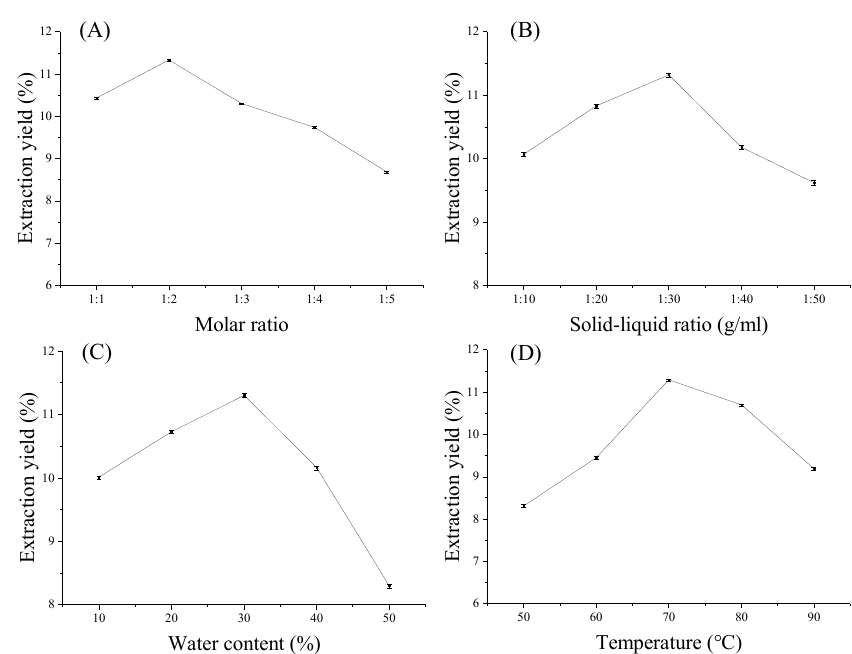
Figure 1. ( A ) Effect of different molar ratios on the extraction yield of crude polysaccharides. Expeimental conditions: water content of 30% (v/v), solid–liquid ratio of 1:30 (g/mL), extraction temperature of 70 °C, sonication time of 30 min, amplitude level of 40%; ( B ) Effect of different solid-liquid ratios on the extraction yield of crude polysaccharides. Expeimental conditions: molar ratio of 1:2, water content of 30% (v/v), extraction temperature of 70 °C, sonication time of 30 min, amplitude level of 40%; ( C ) Effect of different water content on the extraction yield of crude polysaccharides. Expeimental conditions: molar ratio of 1:2, solid–liquid ratio of 1:30 (g/mL), extraction temperature of 70 °C, sonication time of 30 min, amplitude level of 40%; ( D ) Effect of different extraction temperature on the extraction yield of crude polysaccharides. Experimental conditions: molar ratio of 1:2, solid-liquid ratio of 1:30 (g/mL), water content of 30% (v/v), sonication time of 30 min, amplitude level of 40%. Each experiment was carried out in triplicate.